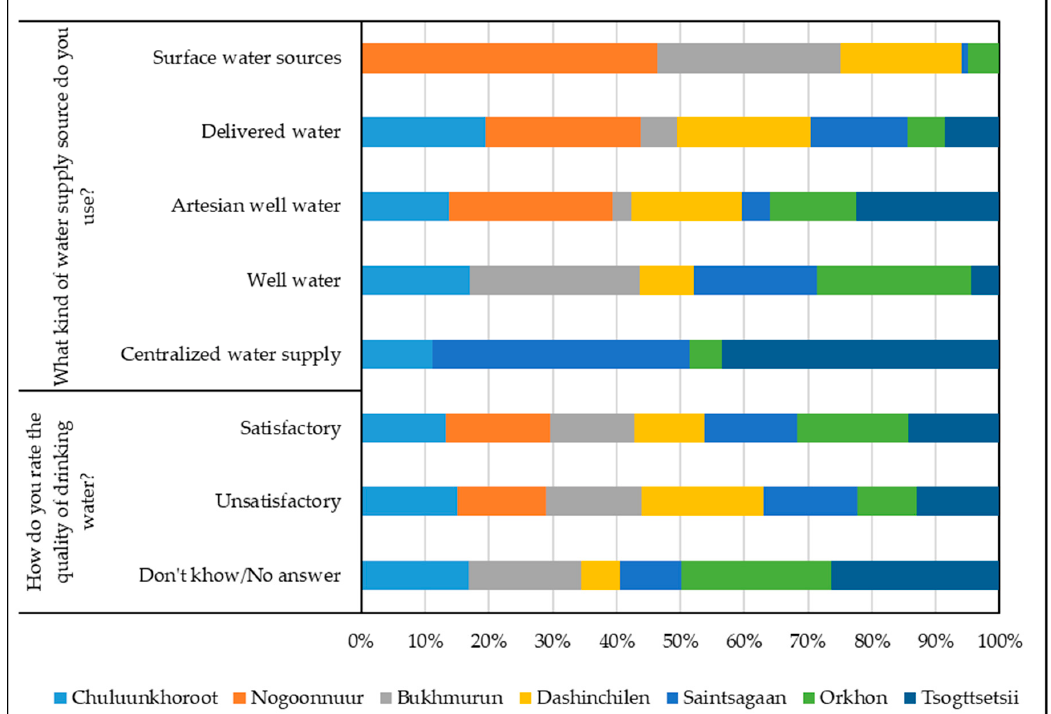
Figure 4. Distribution of answers to questions about water supply and water quality.